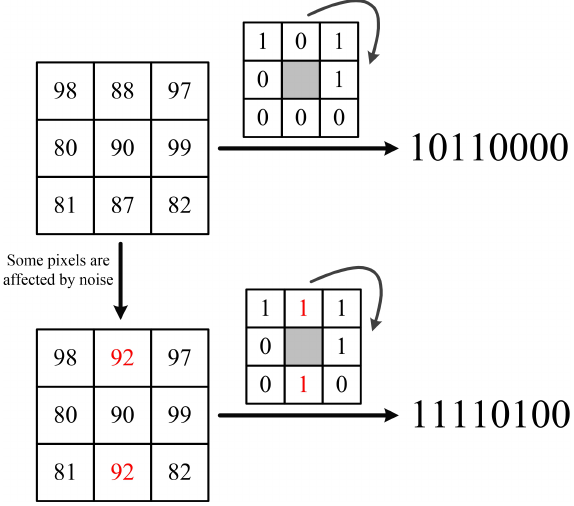
Figure 3. The influence of noise to the LBP coding